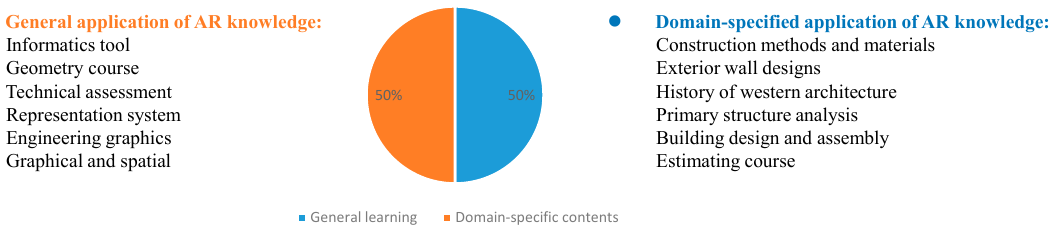
Figure 4. The percentage of application domains.